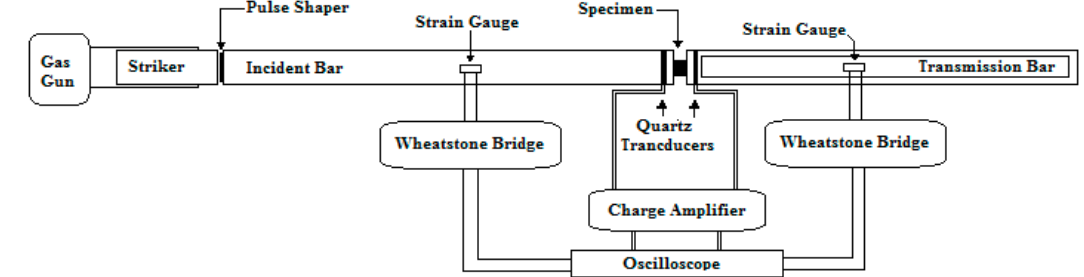
Figure 1. A schematic of the Kolsky setup.